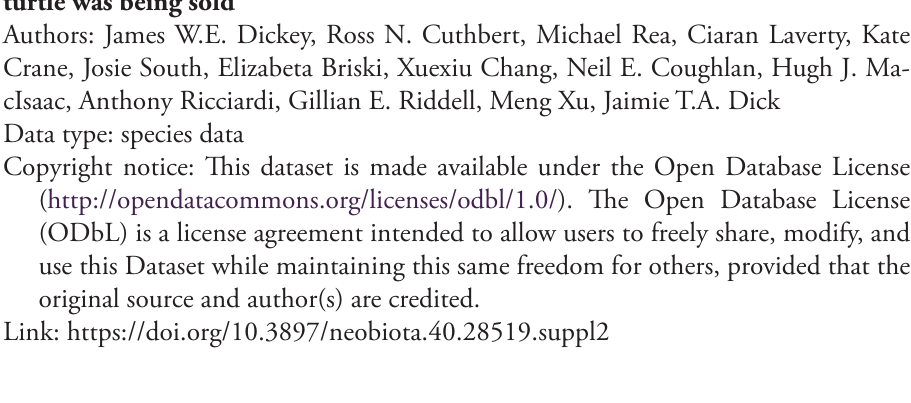
Table S2. Summary of the GB online survey outlining which of the four species of turtle was being